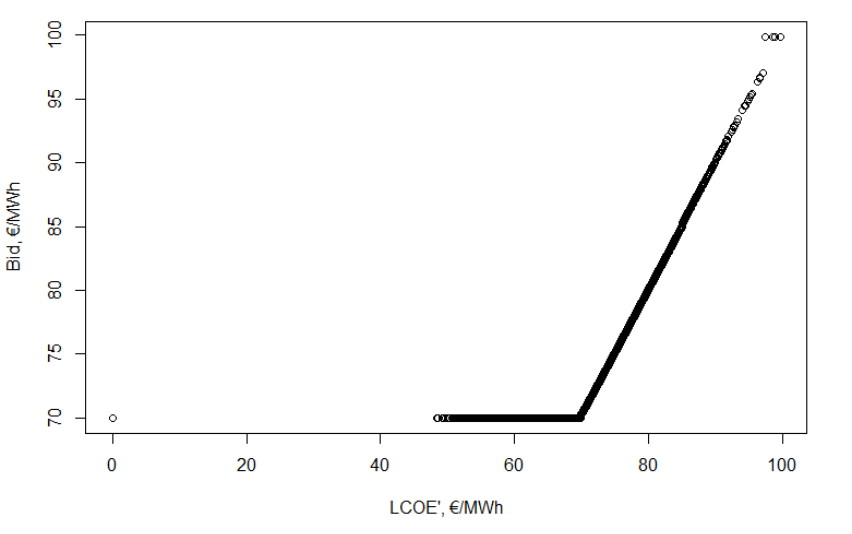
Figure 12. Optimal bid function assuming f N bidding strategy from others, source: own figure. To check that the assumed and optimal bidding strategies are the same the (N)RMSE value can be applied: RMSE is 0.10, while NRMSE is 0.15% (mean values are 73.39 and 73.45). This is lower than the pre-defined stopping criterion 0.2%. This means that the two bid functions are very close to each other. From this it can be concluded that the assumed bid function, f N is a Nash-equilibrium bidding strategy: when every other player bids according to this function, then the best response is this function, thus when all players use this bid function it is a